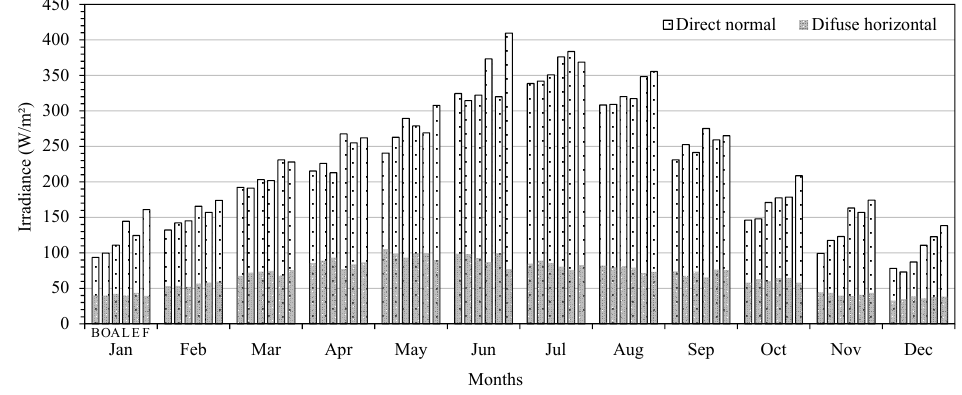
Figure 6. Weather data for the six locations (source: [32]): Average monthly air temperature and relative humidity. Nomenclature: B—Bragança; O—Oporto; A—Aveiro; L—Lisbon; E— É vora; F—Faro.